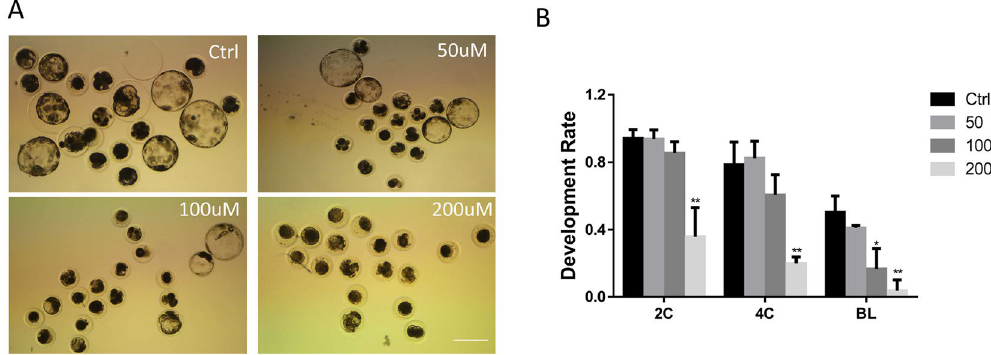
Figure 1. Effect of BPA on porcine early embryonic development. ( A ) Effect of different BPA concentrations on embryonic development. ( B ) The rate of embryonic development. * P < 0.05, ** P < 0.01. Ctrl, control; Treat, treatment. 2 C: 2-cell; 4 C: 4-cell; BL: Blastocyst. Scale bar: 200 μ